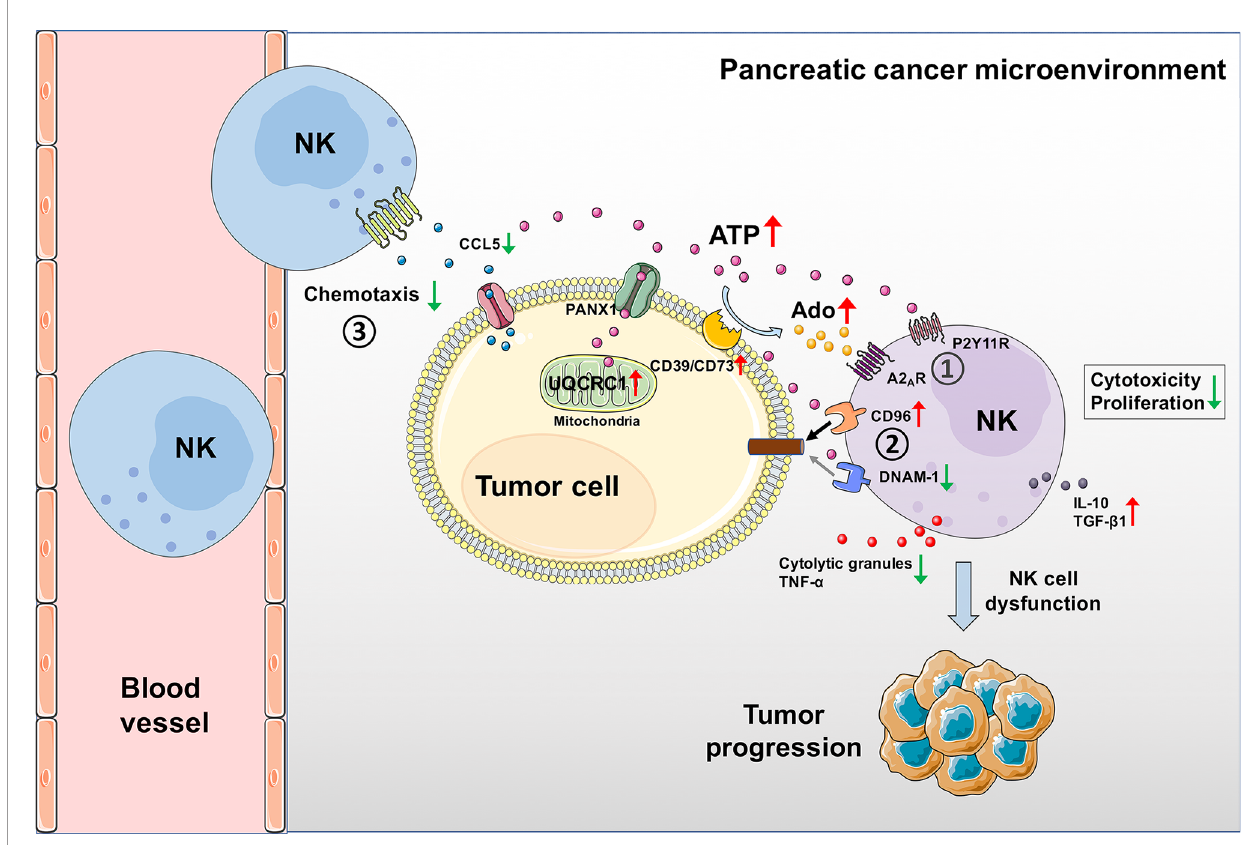
FIGURE 7 | Schematic diagram of UQCRC1-induced inhibition of NK cells in the PC microenvironment. UQCRC1 upregulation in PC cells impairs the cytotoxicity and migration of NK cells by generating extra eATP, thereby promoting tumor progression. The overproduced eATP exerts its suppressive effect on NK cells in three ways: (1) Increased eATP can be hydrolyzed to eAdo by elevated expression of CD39 and CD73 on the surface of UQCRC1-overexpressing cancer cells. The eATP and eAdo inhibit the cytotoxicity and proliferation of NK cells by engaging P2Y11R and A 2A R. (2) Increased eATP induces NK cells to a more inhibitory phenotype by reducing DNAM-1 expression and increasing CD96 expression, re fl ected by elevated levels of IL-10 and TGF- b 1. (3) Increased eATP decreases the chemotaxis of NK cells by reducing the CCL5 expression and secretion of UQCRC1-overexpressing cancer